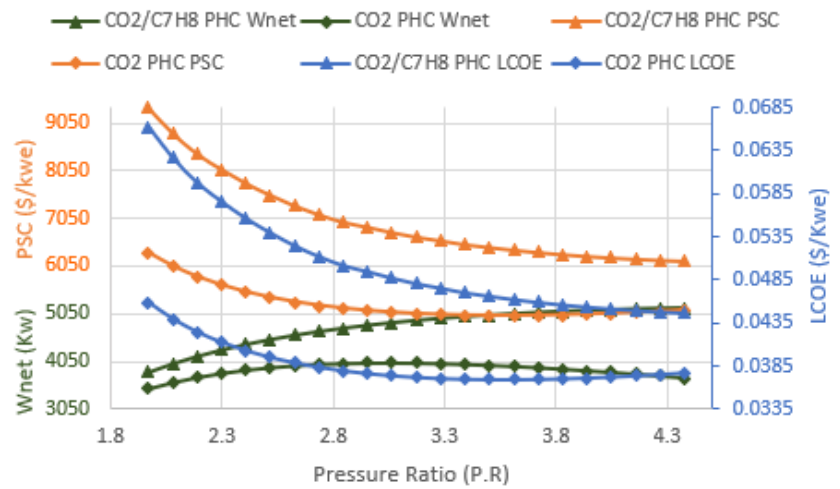
Figure 8. Power output, plant-specific cost and levelized cost of electricity for CO 2 PHC and 0.9CO 2 /0.1C 7 H 8 PHC with respect to pressure ratio. 0.9CO 2 / 0.1C 7 H 8 PHC with respect to pressure ratio.